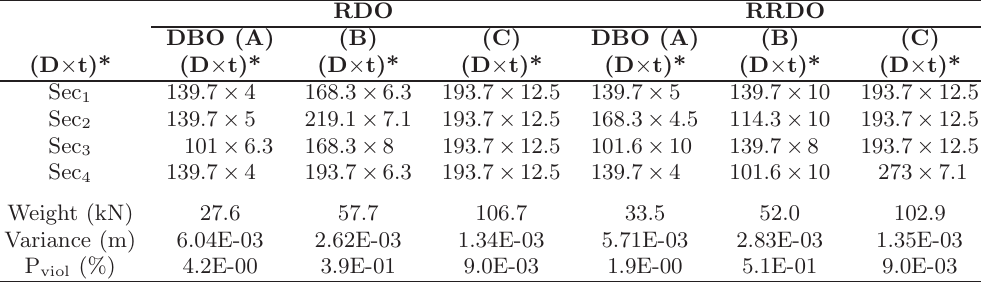
Table 2. 39-bar truss example: characteristic optimal solutions.